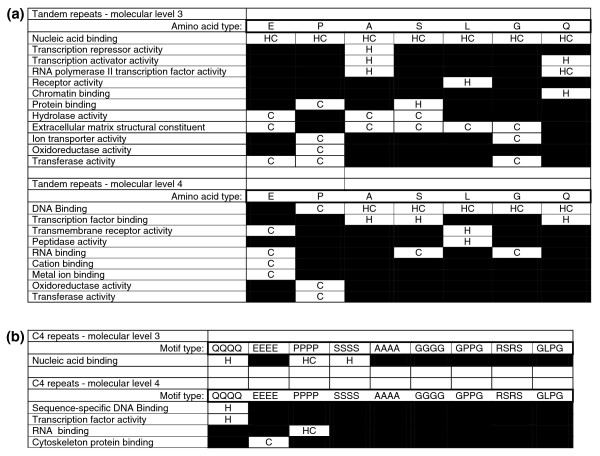
Overrepresented Gene Ontology terms in human or chicken proteins containing AARs. (a) Tandem repeats; (b) C4 repeats. Terms showing significant overrepresentation after correction for multiple testing are labeled according to the species in which overrepresentation was observed: H, human; C, chicken; HC, both. GO terms were tested for overrepresented at two levels: level 3 and level 4. The terms are separated by level in the figure.